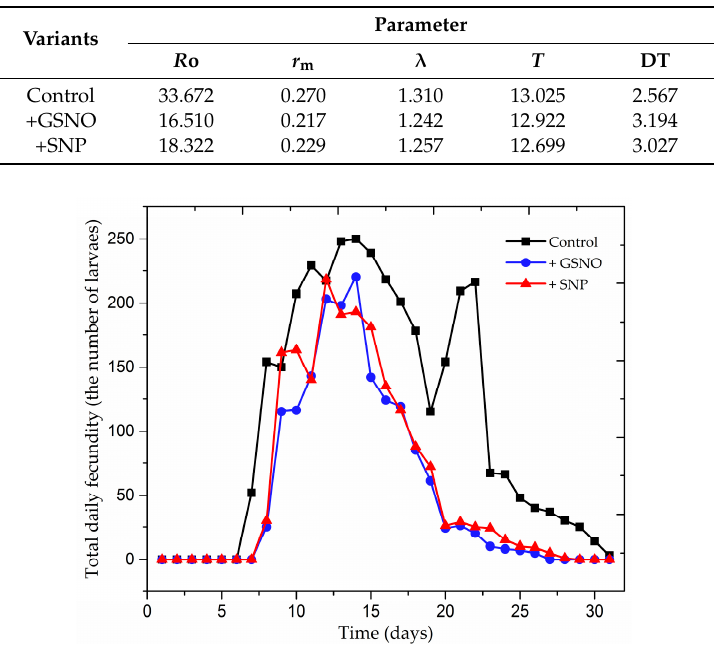
Table 2. Population and life table parameters of apterous A. pisum on P. sativum seedlings exposed to pretreatment with an NO donor or with no pretreatment (control). Ro, net reproductive rate; r m , intrinsic rate of increase; λ , finite rate of increase; T , generation time; DT, doubling time.